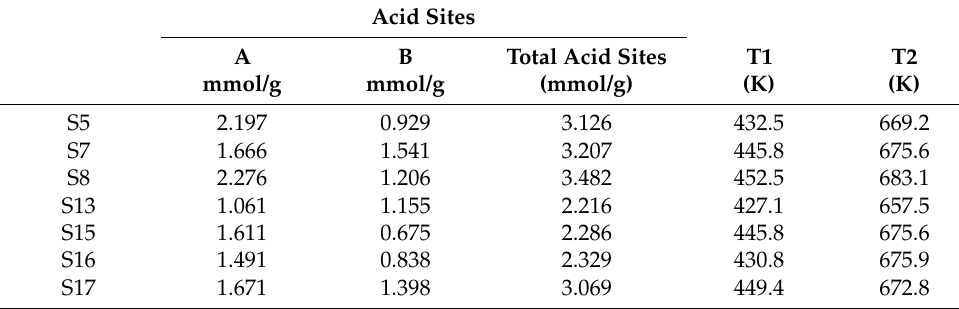
Figure 10. NH 3 -TPD analysis of the synthesized SAPO-34 particles. Table 4. NH 3 -TPD data for the synthesized SAPO-34